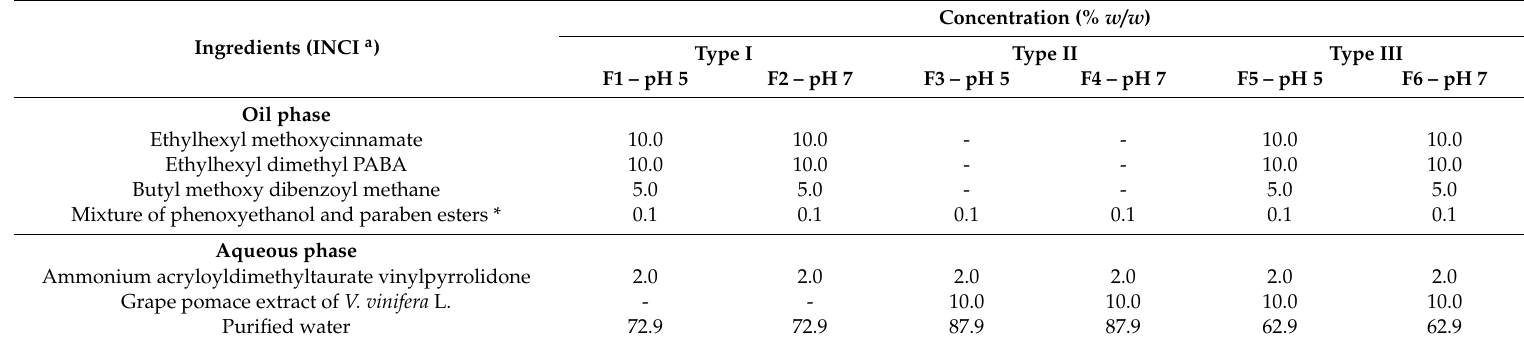
Table 1. Qualitative and quantitative composition (% w / w ) of the sunscreens with and without grape pomace extract (F1 to F6) at two pH